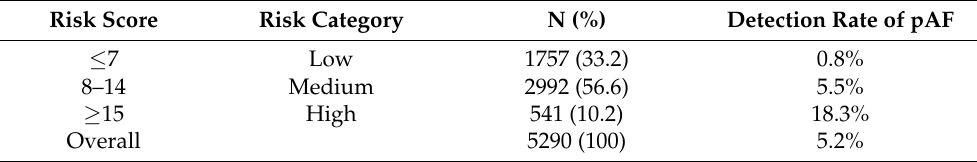
Table 3. Risk categories and corresponding detection rate of paroxysmal atrial fibrillation.